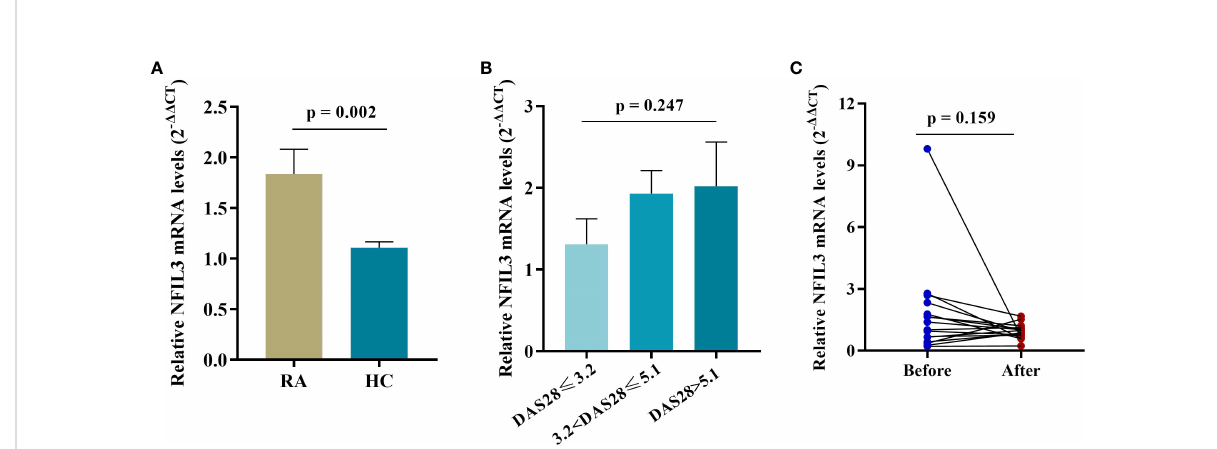
FIGURE 2 NFIL3 expression in PBMCs from newly diagnosed RA patients and healthy controls. (A) Comparison of NFIL3 expression between RA and HC groups using qRT-PCR. (B) Differences in NFIL3 expression among RA patients with low, moderate, and high disease activity. (C) Alterations of NFIL3 expression before and after treatment. RA patients were divided into three groups according to DAS28-ESR score. Low disease activity, DAS28 ≤ 3.2; moderate disease activity, 3.2 < disease activity ≤ 5.1; high disease activity, DAS28 > 5.1. GAPDH was used as a reference gene for data normalization. PBMCs, peripheral blood mononuclear cells; RA, rheumatoid arthritis; HC, healthy